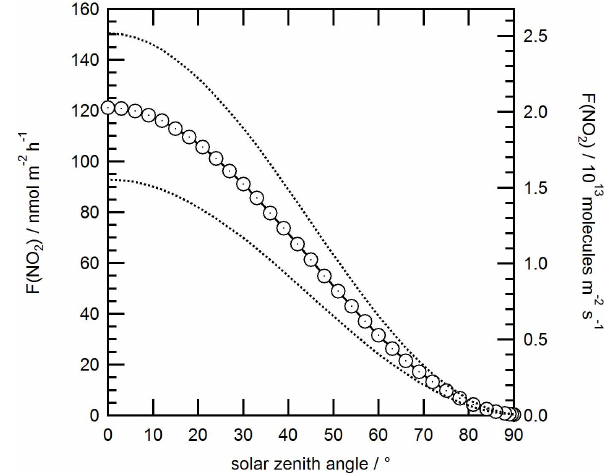
Fig. 5. Maximum potential flux of NO 2 from the snowpack versus solar zenith angle, assuming all photoproduced NO 2 from nitrate photolysis is liberated to the atmosphere. The snowpack stratigra- phy is taken from Table 1. The central line (dotted circles) is cal- culated using the dotted circled nitrate profile from Fig. 2. The dot- ted lines above and below represent minimum and maximum NO 2 depth-integrated production rates calculated using the other mea- sured nitrate profiles shown in Fig.